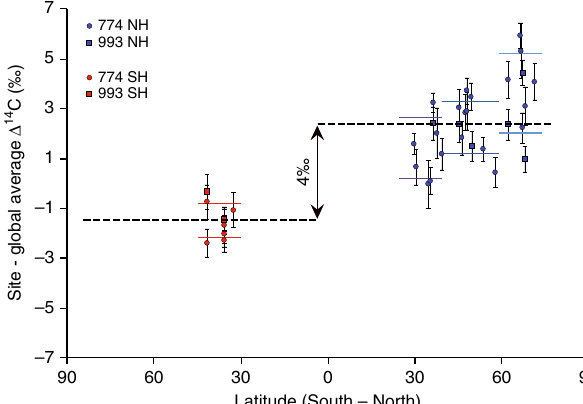
Fig. 3 COSMIC gradient. The 14 C content of individual tree-ring site records averaged over 11-year intervals from 770 – 780 and 990 – 1000 CE. Horizontal lines indicate atmospheric radiocarbon zones 17 . Grey lines are standard errors of the tree-ring site records. Linear trends within the NH and across both hemispheres are R 2 = 0.29 and 0.71, respectively (not